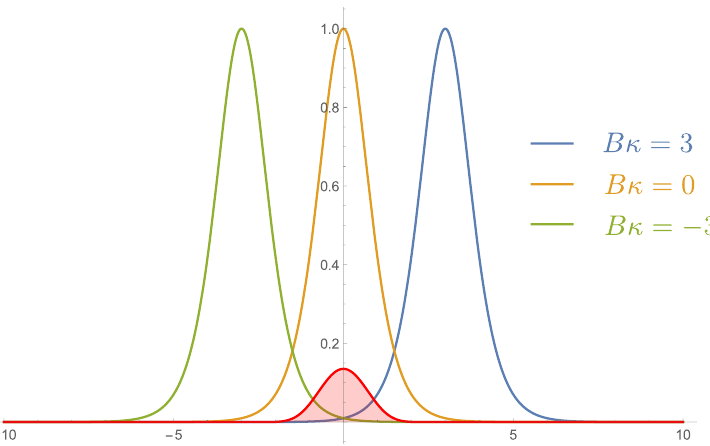
Figure 5 . Plot of f exp ( (cid:18) ) and f D ( (cid:18); B(cid:20) ) with B(cid:20) = 0 ; (cid:6) 3. The red shaded line denote f exp ( (cid:18) ) with mr =